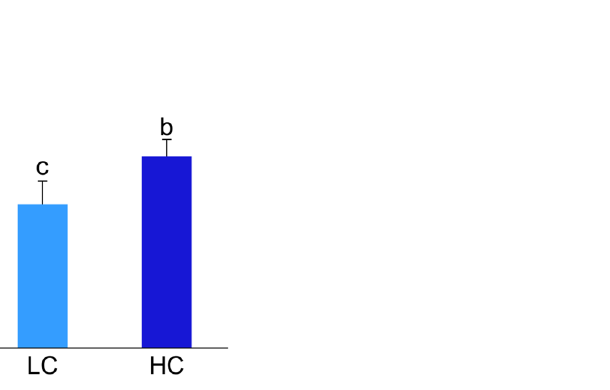
Figure 3. Quantitative analysis of MDA and AGEs generation induced by d-galactose in the presence of cacao. ( a ) Serum MDA level; ( b ) Serum AGEs level; ( c ) Liver MDA level; ( d ) Brain MDA level . Values represent mean ± SD, n = 8; Means for a variable with different letters (a, b, c) differ significantly ( p < 0.05). C, control; G, d-galactose-induced aging; LC, d-galactose injection with 10% cacao powder mixed diet; HC, d-galactose injection with 16% cacao powder mixed diet.